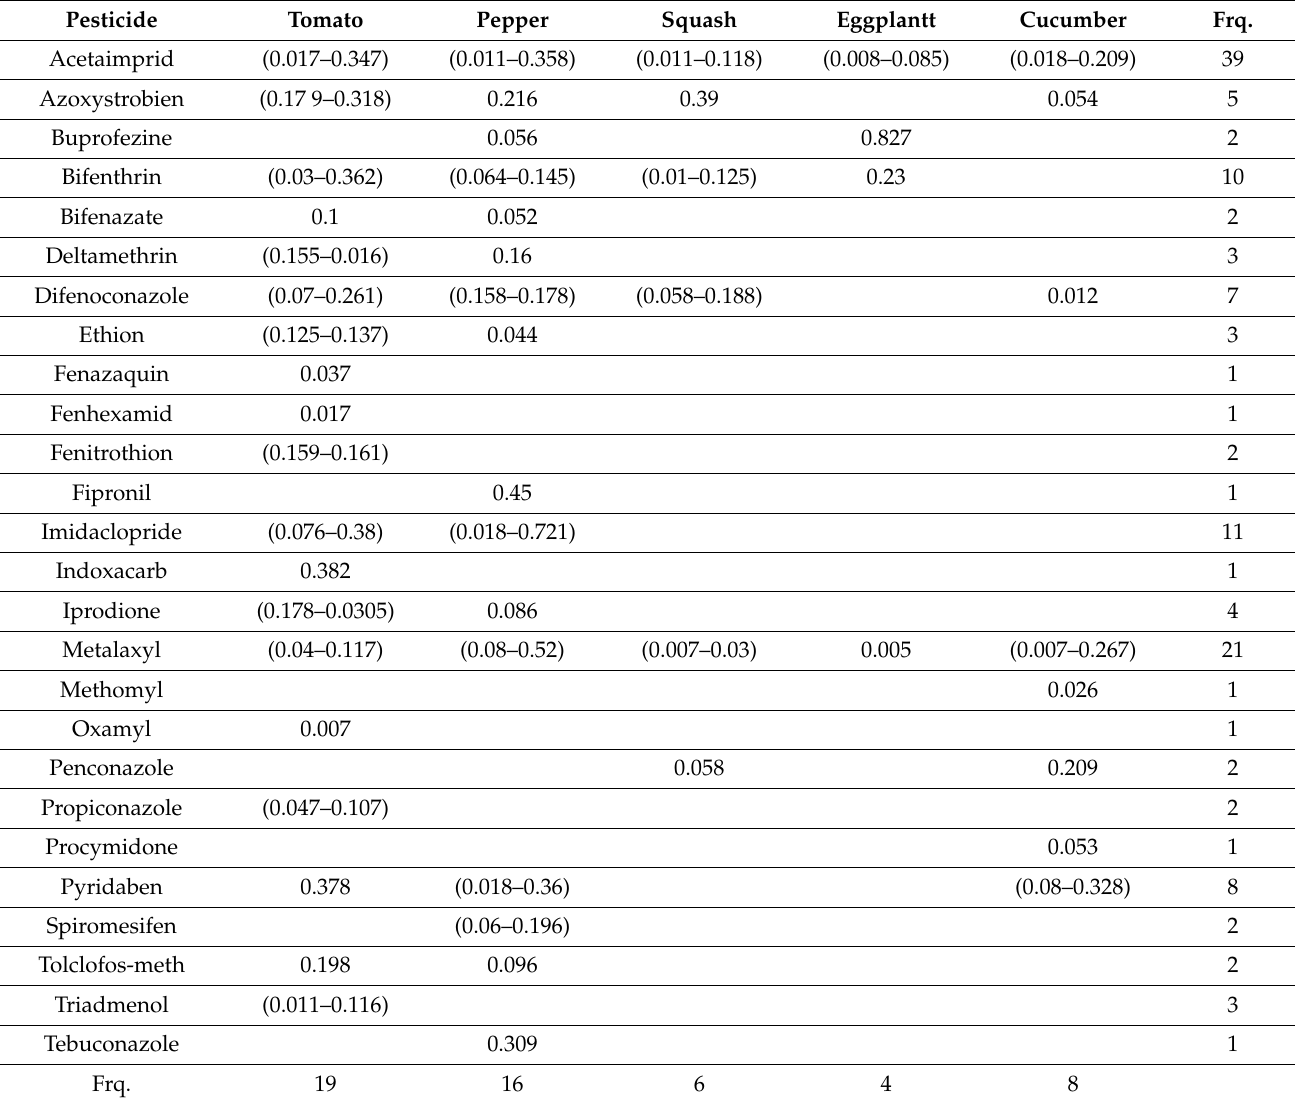
Table 1. Demonstrates the frequency of occurrence of